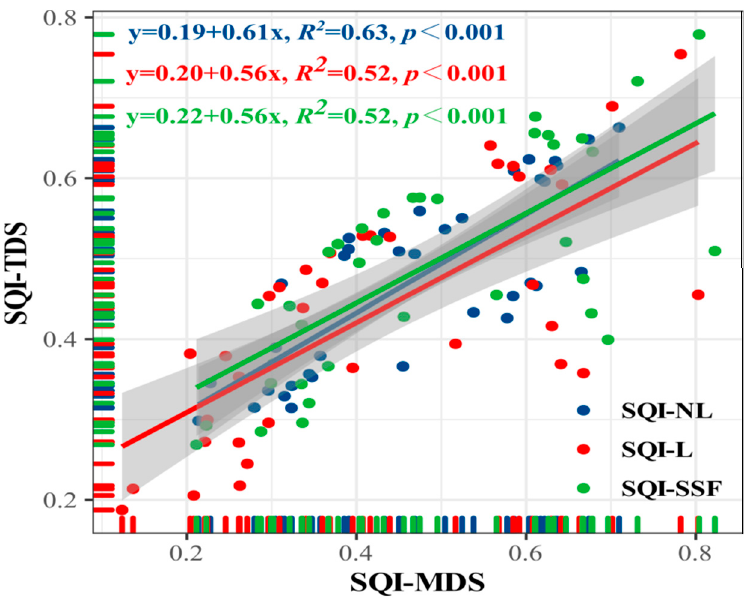
Figure 6. Analysis of soil quality index of the minimum dataset (MDS) and total dataset (TDS) by three scoring methods.